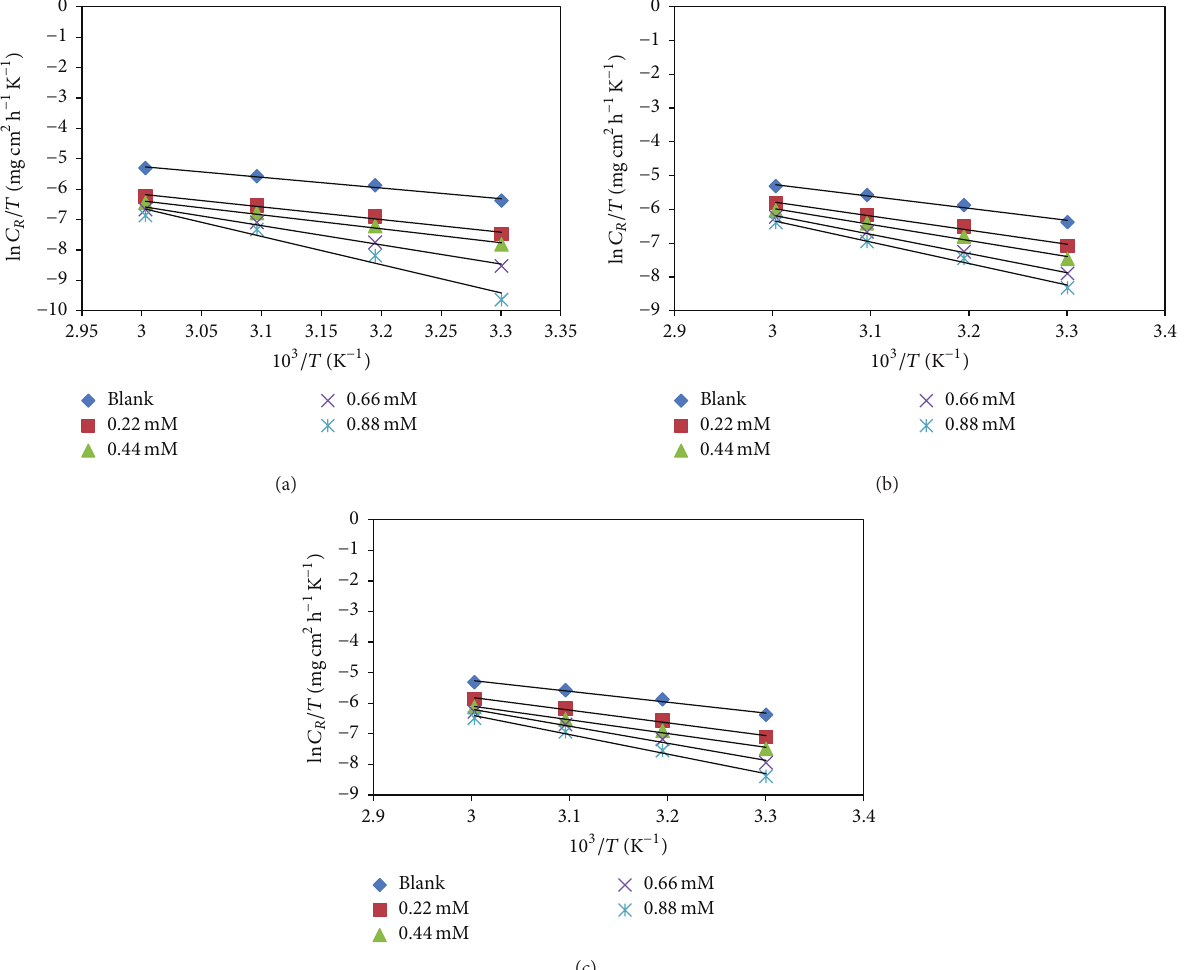
A graph of 𝐶/𝜃 versus 𝐶 was drawn for all three inhibitors and obtained straight lines (Figure 4). The slope of straight lines was approximately 1 and regression coefficient